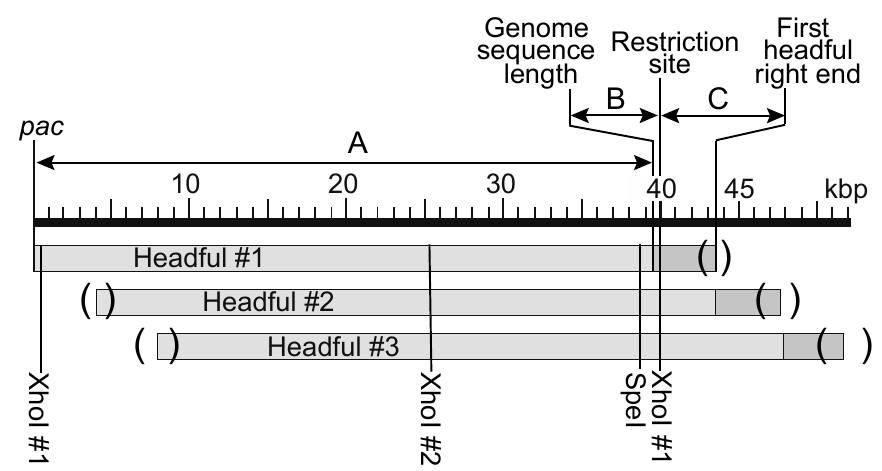
Figure 1. Location of the right end of first DNA headful in P22 packaging series. The first three packaged DNA molecules of a sequential headful series are shown as bars below aligned to the P22 UC-0937 genome kbp scale (its genome sequence is 39,521 bp long); in each headful light gray denotes the leftmost one genome sequence long region and the dark gray denotes the terminal redundancy. Parentheses indicate that there is a range of cleavage sites in different virions due to imprecision in the phage’s headful measuring device. Locations of relevant restriction endonuclease cleavage sites are shown below. The arrows labeled A, B and C above show that the first headful DNA length is determined by the sum of the genome length (arrow A) + distance from there to the restriction site whose cleavage created that fragment (arrow B; XhoI in the case shown) + the first headful right-end restriction fragment length (arrow C).